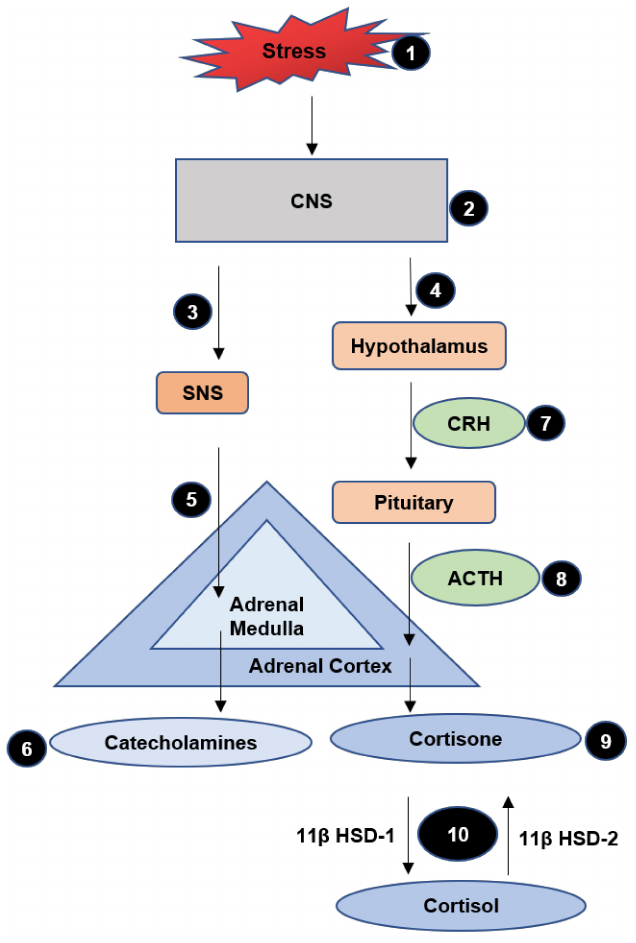
Figure 2. Response of the body to stress. A stressor ( 1 ), causes the central nervous system (CNS) ( 2 ), to activate the sympathetic nervous system (SNS) ( 3 ), and hypothalamus–pituitary–adrenal axis (HPA) ( 4 ). Sympathetic nervous system (SNS) activates adrenal medulla ( 5 ), which releases catecholamines ( 6 ). Hypothalamus releases corticotropin-releasing hormone (CRH) ( 7 ), which causes the pituitary gland to release adrenocorticotropic hormone (ACTH) ( 8 ). Adrenocorticotropic hormone (ACTH) results in the release of cortisone ( 9 ), from adrenal cortex. Cortisone is activated by the dehydrogenase type 2 (11- β HSD-2) to cortisone, in the target organs ( 10